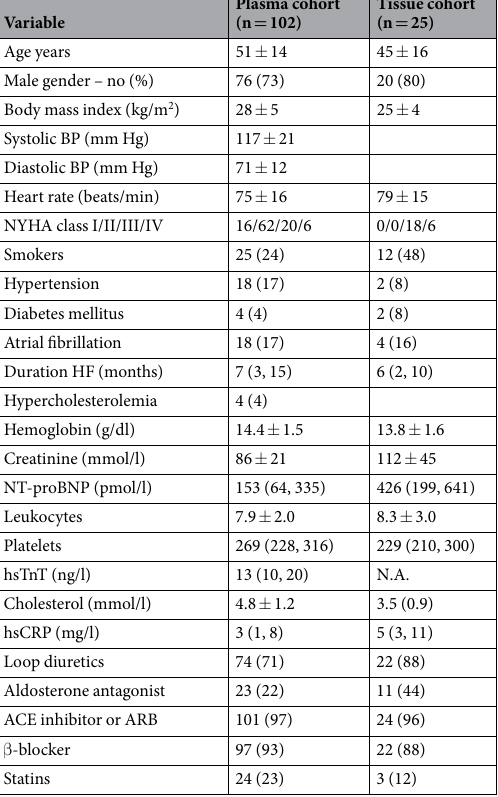
sFRP3 protein ratio correlated positively with NT-proBNP levels, left atrial diameter, pulmonary capillary wedge pressure and in particular pulmonary artery systolic pressure (PASP) (Fig. 3C). Patients with PASP > 40 mm Hg (median 51), indicating pulmonary hypertension, had a markedly higher Wnt5a/sFRP3 ratio (Fig. 3D). In preliminary studies we evaluated mRNA levels of typical canonical (Wnt3a, Wnt8a) and non-canonical (Wnt5a and Wnt11) Wnt ligands in myocardial tissue from DCM patients and found that the non-canonical ligands were expressed with the highest levels of Wnt5a, while the canonical Wnt3a and Wnt8 were hardly expressed (CT values from RT-PCR > 35) (Fig. 3E). A similar pattern with expression of non-canonical Wnt ligands was observed when evaluating expression patterns from GEO repositories although some differences were observed in microarrays from the RV of DCM patients and RNAseq from the LV (Fig. 3F). Wnt5a and sFRP3 effects on NFAT signaling.